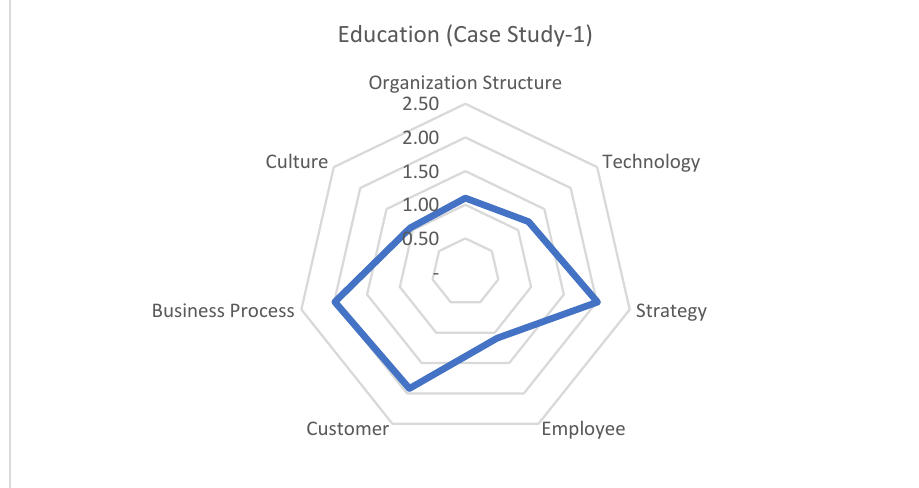
Figure 8. Maturity Level (Case 1).